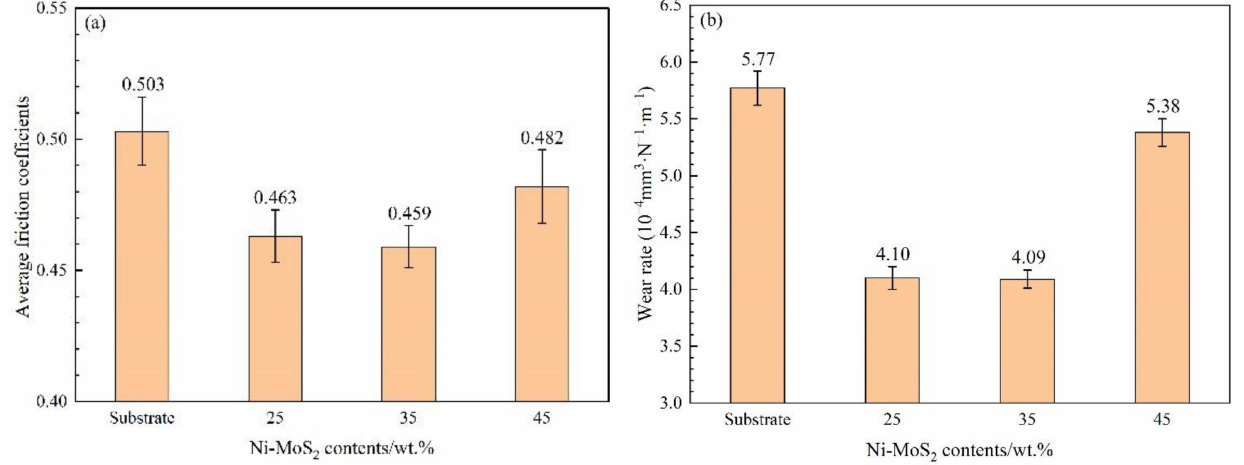
Figure 12. The parameters of the friction and wear test. ( a ) Average friction coefficients. ( b ) Wear